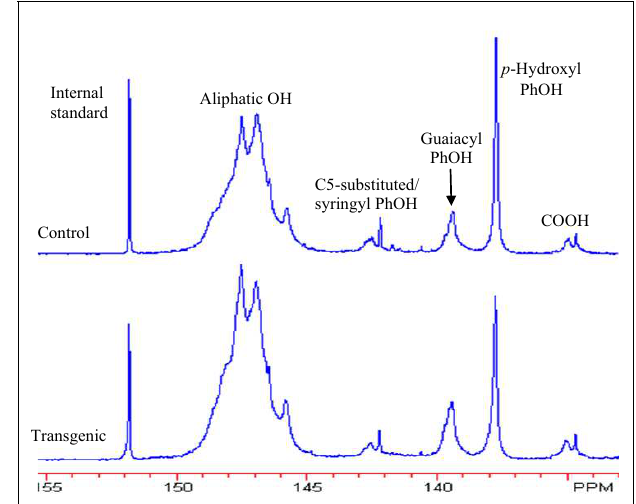
Table 1 | Signal assignments of chemical structures in 13 C- 1 H HSQC FIGURE 6 | 31 P NMR spectra of lignin samples isolated from wild-type and COMT transgenic switchgrass .Top: control; bottom: transgenic.